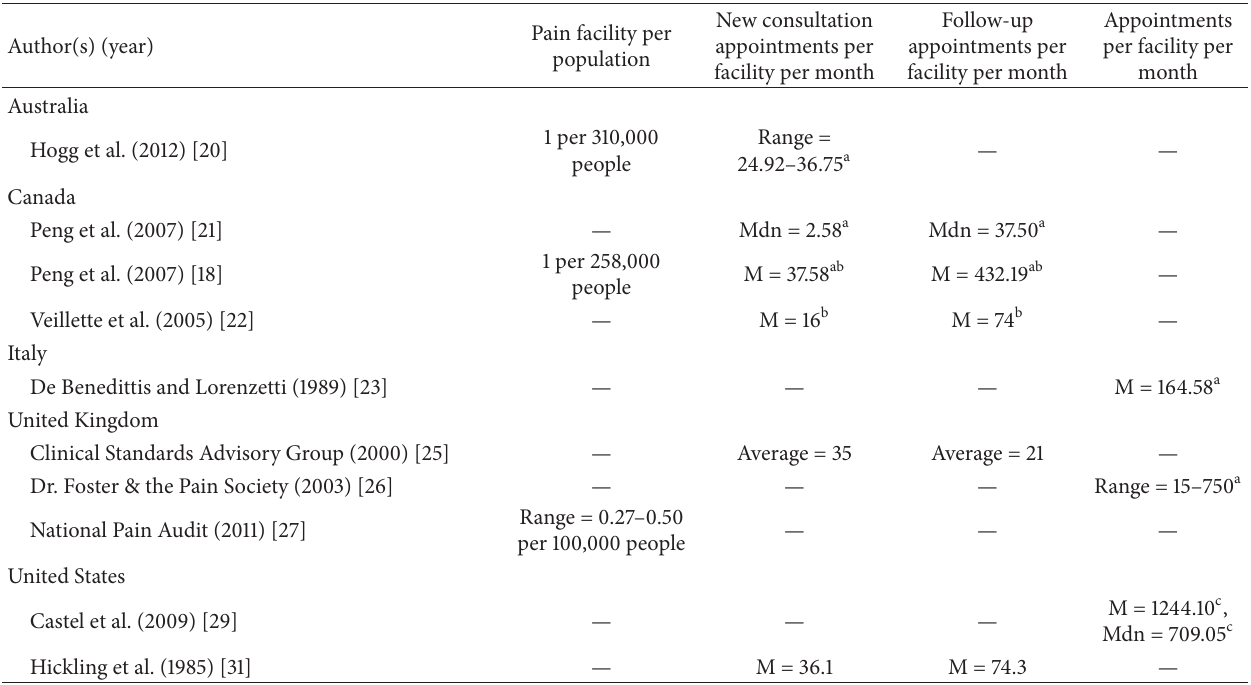
Table 2: Availability and caseload of pain treatment